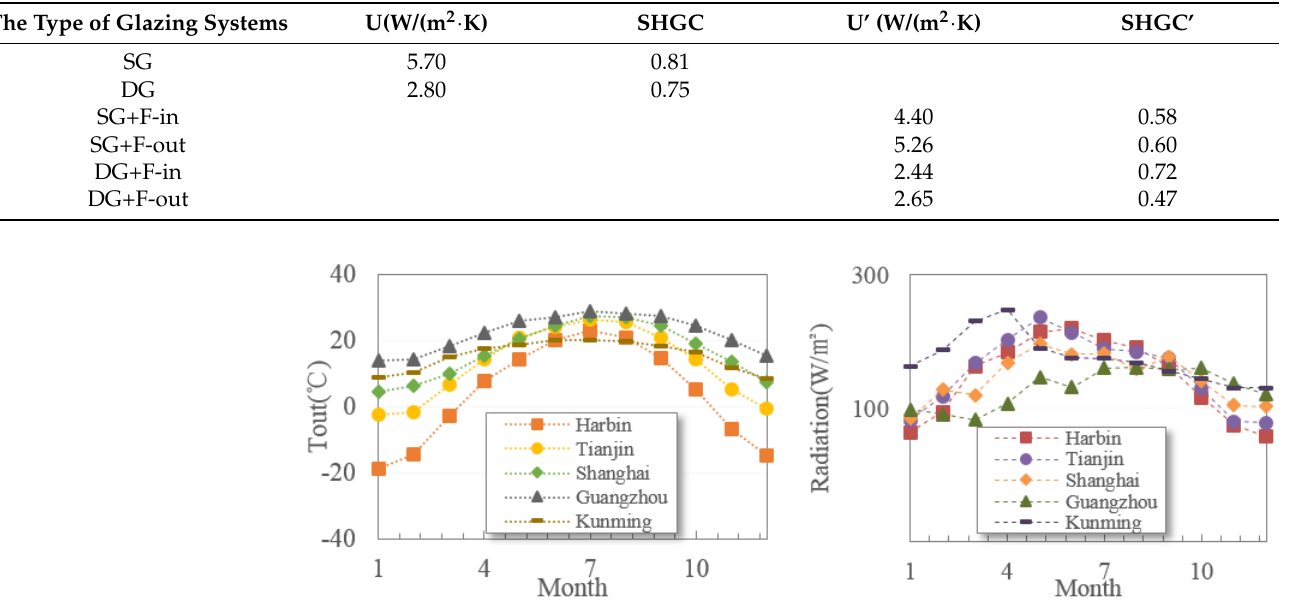
Table 2. The thermal parameters of glazing systems.